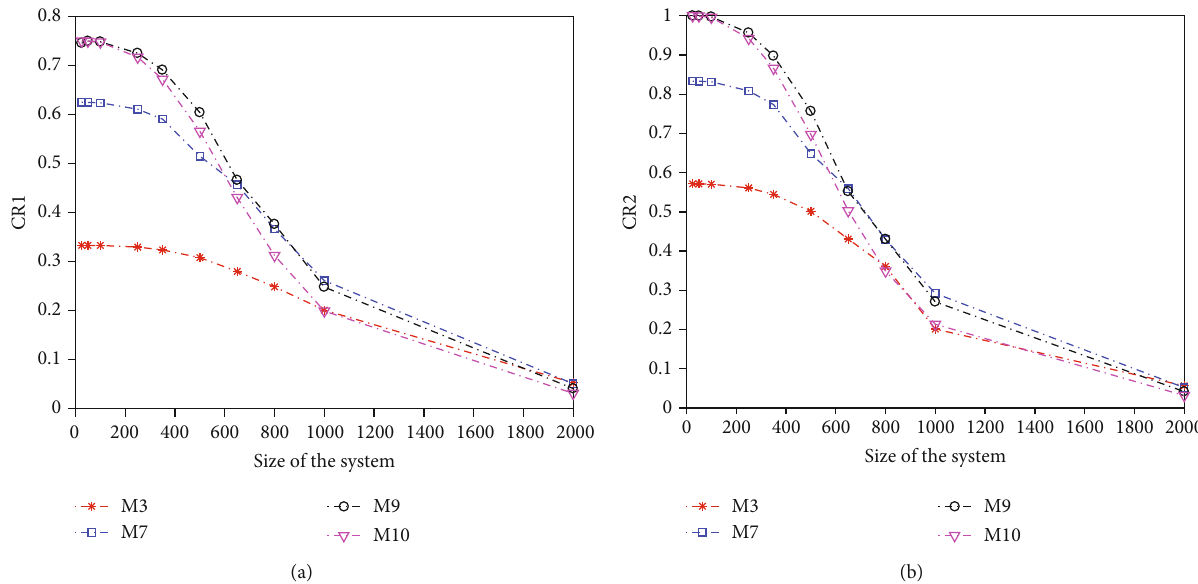
Figure 1: Values of CR1 (a) and CR2 (b) for solving Test Problem 1 by algorithms M3, M7, M9, and